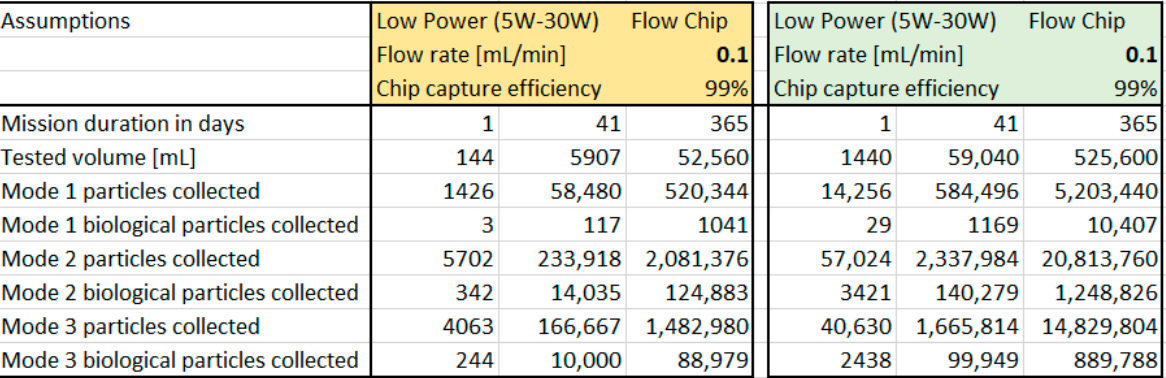
Figure 6. The Fluid-Screen capture efficiency depends on the power requirements and the flow rate [17]. For example, under low power requirements (1.5 W–30 W) and high flow rate of 1 mL/min the capture efficiency in standard FS conditions [17] is only 30%. The capture efficiency raises dramatically if the flow rate is slow, 0.1 mL/min, or more power is provided to the system. The calculated capture efficiency does not consider the potential challenges posed by the sulfuric acid environment of the clouds (Section 4). Such challenges to the performance of FS System would have to be assessed separately by a dedicated experimental laboratory program. Estimated number of biological particles that would be captured on Fluid-Screen Chip follows the assumptions of the Venus Sampling—Flow Rate and Sampling Time Calculation model developed by prof. Christopher E. Carr and Dr. Rachel Moore for the VLF Mission Study [23].